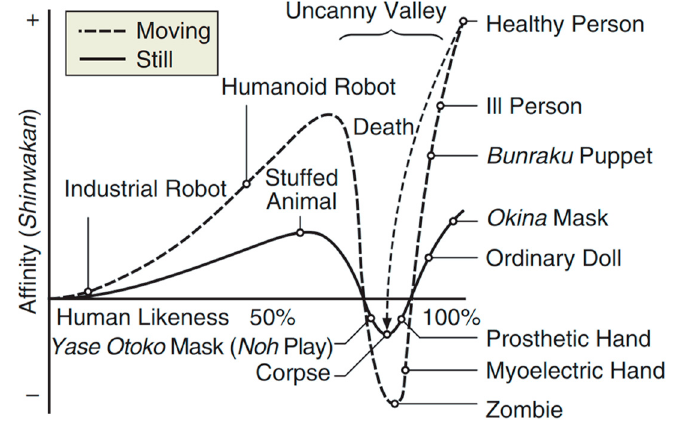
Figure 4. Graph depicting the Uncanny Valley, introduced by Masahiro Mori in 1970 [61], translated and redrawn by Karl F. MacDorman and Norri Kageki in consultation with Mori [62]. Courtesy of Karl F. MacDorman.